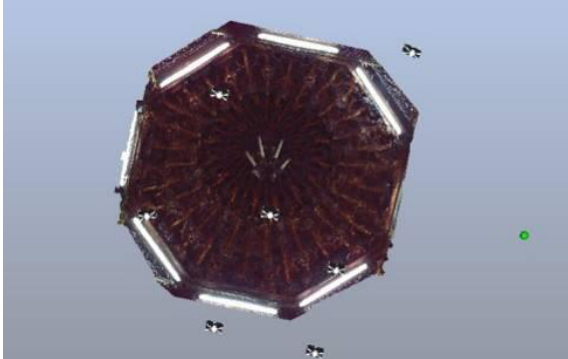
Figure 10 Exportation of point cloud data from FARO and point reduction